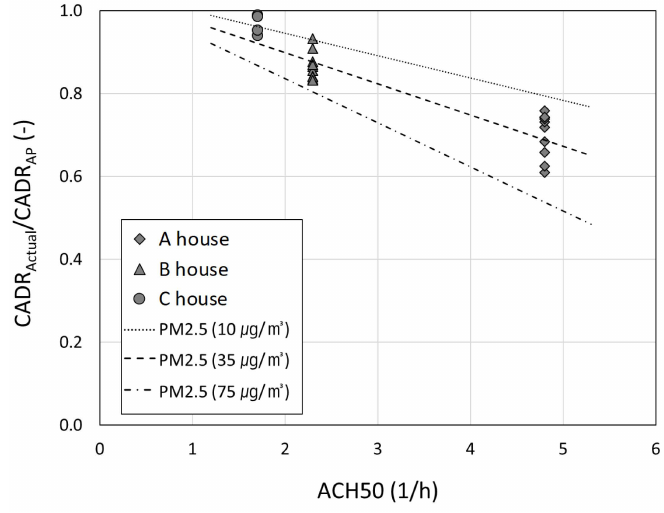
Figure 9. Comparison of experimental and theoretical CADR Actual to standard CADR AP at different PM 2.5 concentrations according to ACH50 of